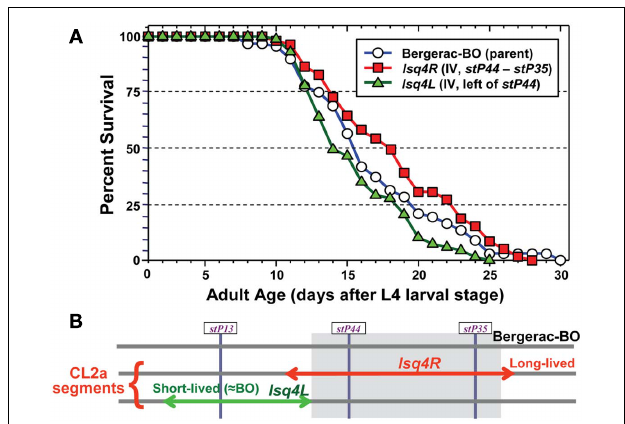
FIGURE 3 | Survivals of C. elegans wild-type strain Bergerac-BO, and two recombinant-congenic lines derived from Bergerac-BO by introgression of stP13–stP35 segments from chromosome IV of CL2a. The lineage designated “4L” retained the Bergerac-BO allele only at marker stP44, while the “lsq4 (center-right)” cohort retained the Bergerac-BO allele for stP13 and stP35. Homozygotes for the introduced lsq4 region were ascertained, expanded, and used to measure survival at 20˚C. Procedures for nematode culture, scoring, and survival analysis are described in Experimental Procedures. Each survival began with 60–65 worms in two dishes, cultured on agar medium. Adult age is measured from the L4 larval-stage; total age is the indicated adult age plus 3days, for Bergerac-BO and strains derived by backcrossing into